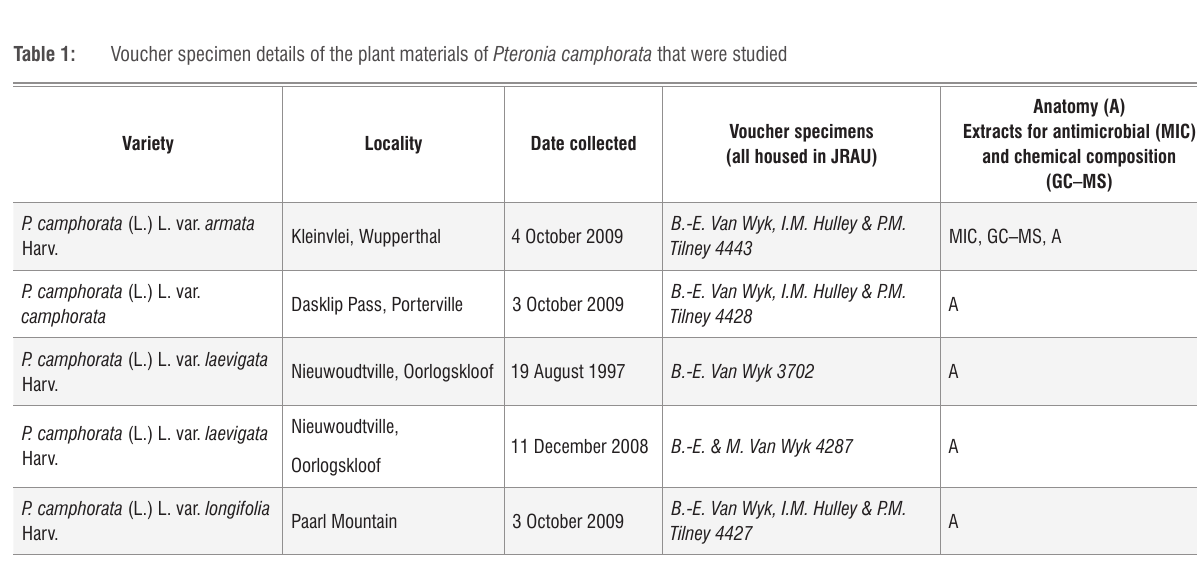
Table 1: Voucher specimen details of the plant materials of Pteronia camphorata that were studied Variety Locality Date collected